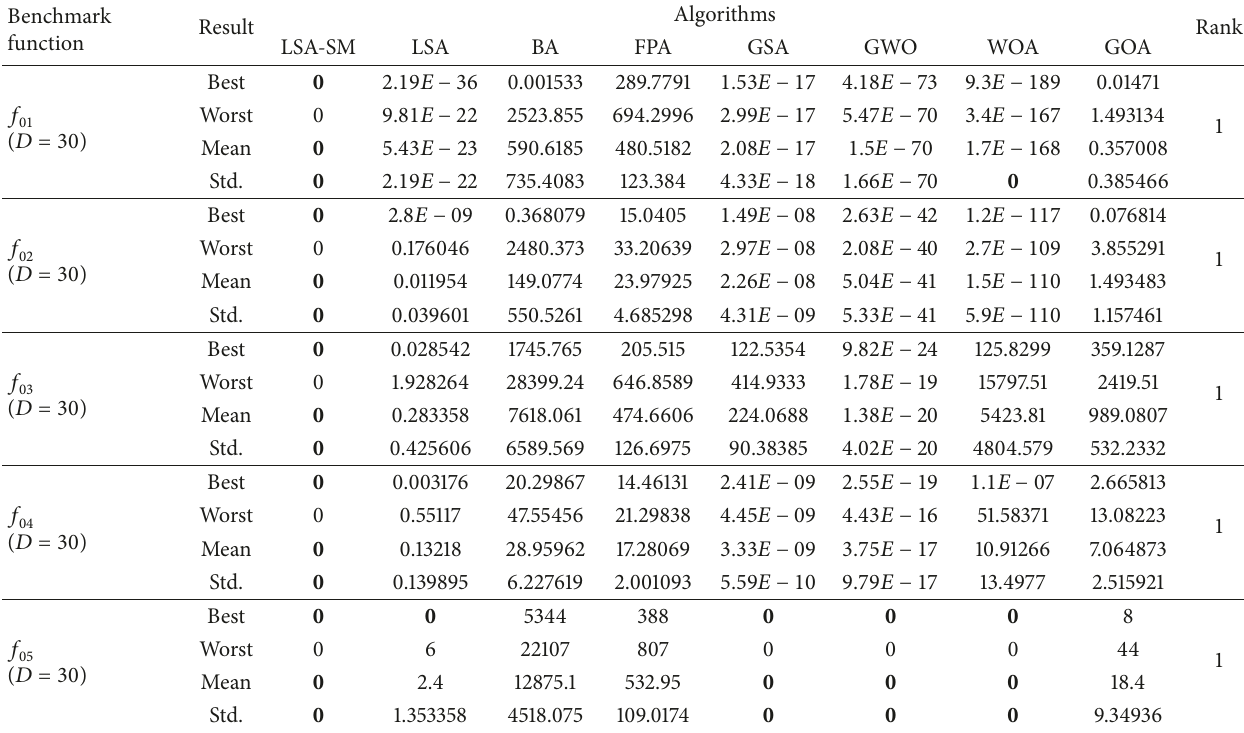
Table 4: Results of unimodal benchmark functions.